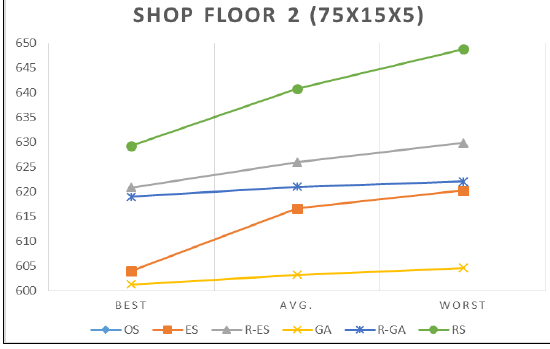
Figure 2. First shop floor results.